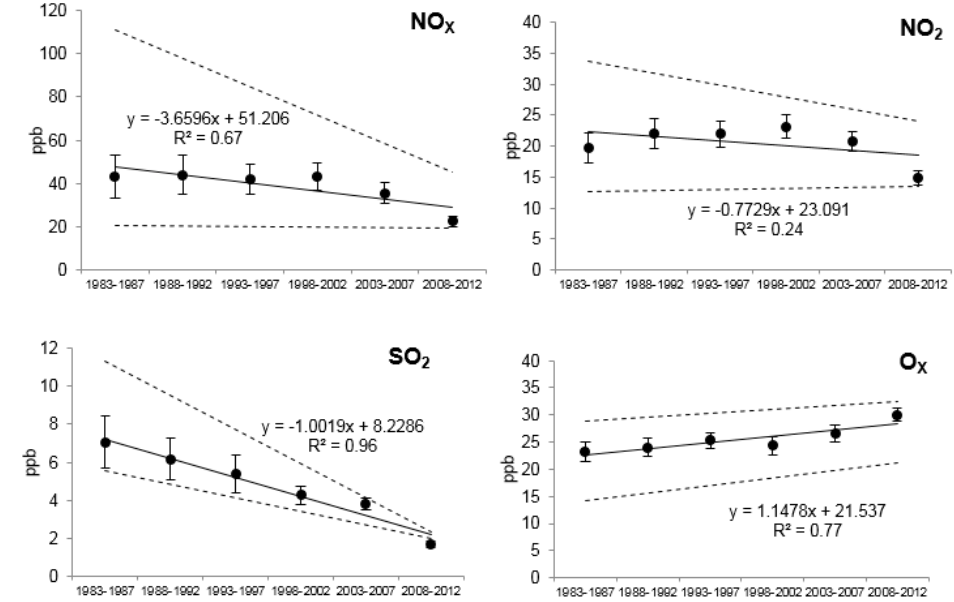
Figure 2. Minimum and maximum (dashed lines), as well as means with added standard error